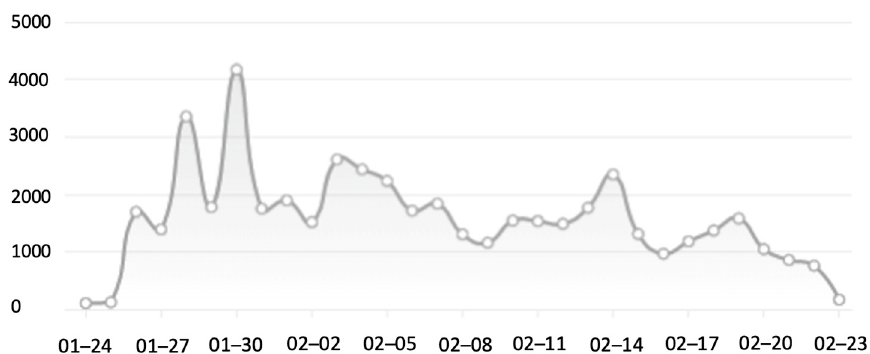
Figure 2. Curve of public attention of early COVID-19 banners. Source: Qingbo database.